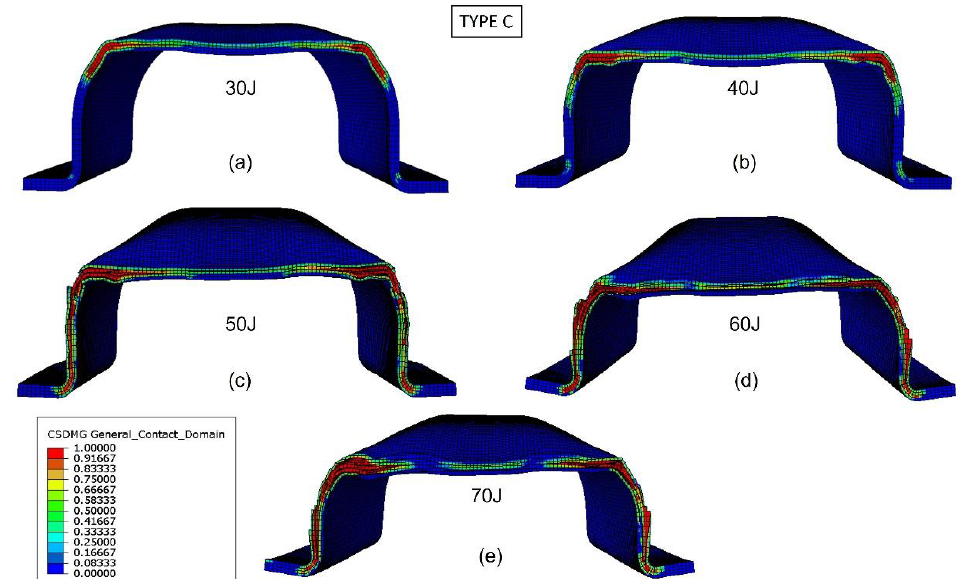
Figure 15. Delamination initiation criterion at the middle cross section of bumper beam Type C. Impact energy: 30 J ( a ), 40 J ( b ), 50 J ( c ), 60 J ( d ), and 70 J ( e ).